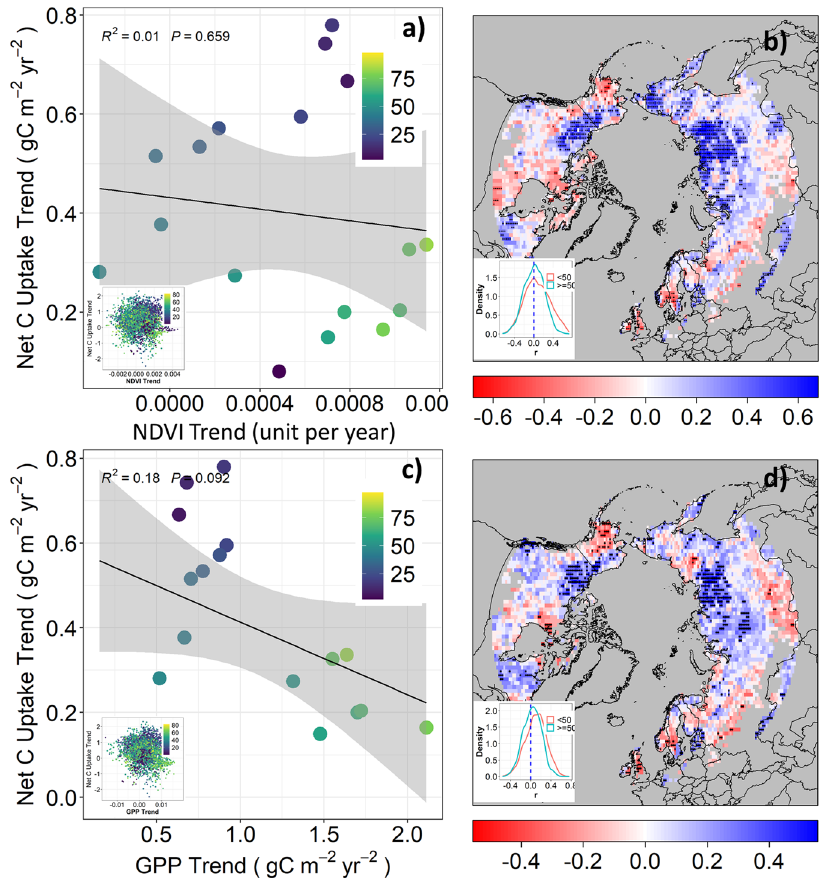
Fig.2|WeaknegativecorrelationsbetweentrendsofproductivityandnetCO 2 uptake suggesting productivity alone cannot explain the different trends of net CO 2 uptake along the tree cover gradient. a , c show correlation between trends of GIMMS NDVI or LUE GPP and net CO 2 uptake trends along the 5% tree cover interval gradient (blue to green), respectively. Insets show the correlation at